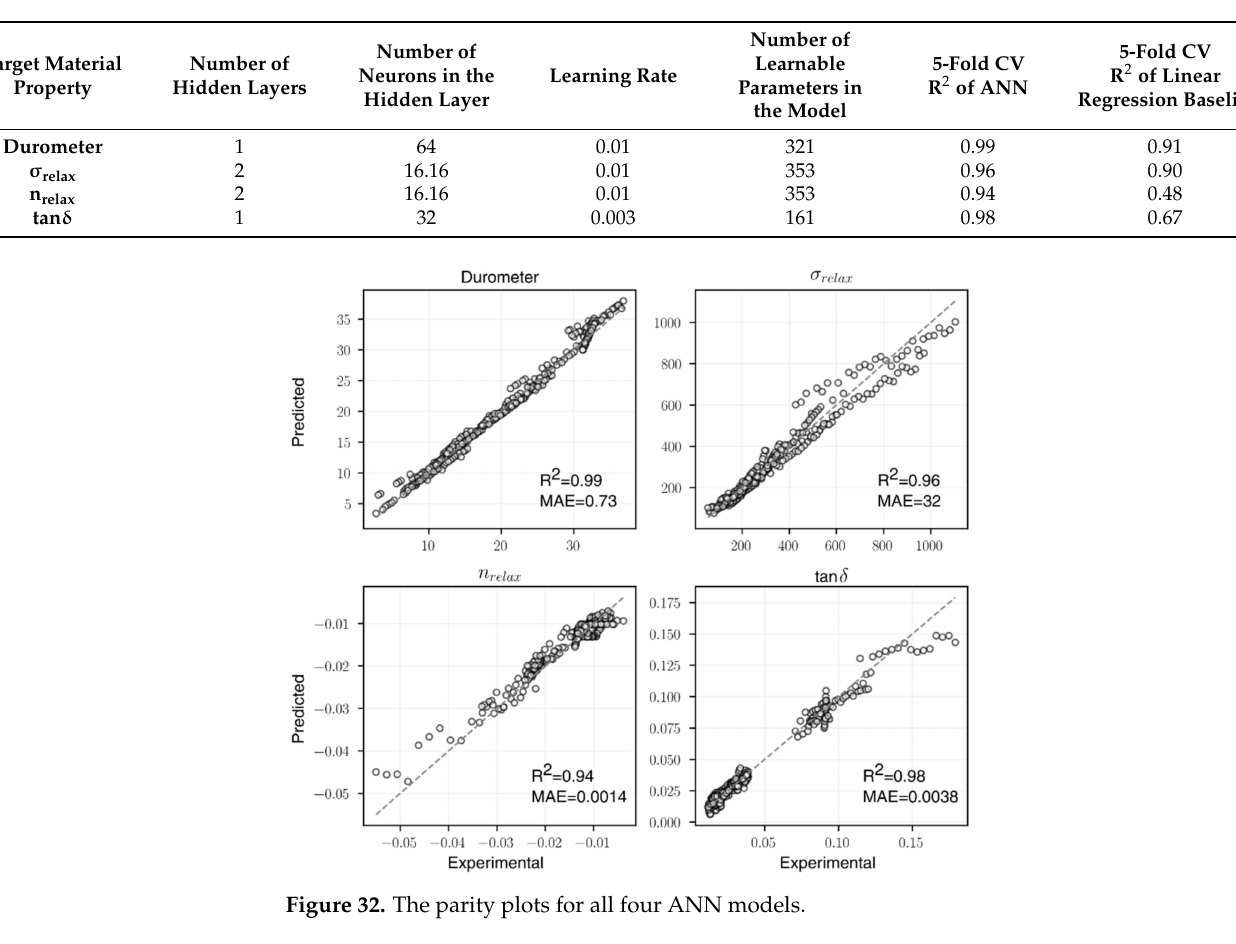
facilitating relaxation as you increase plasticizer